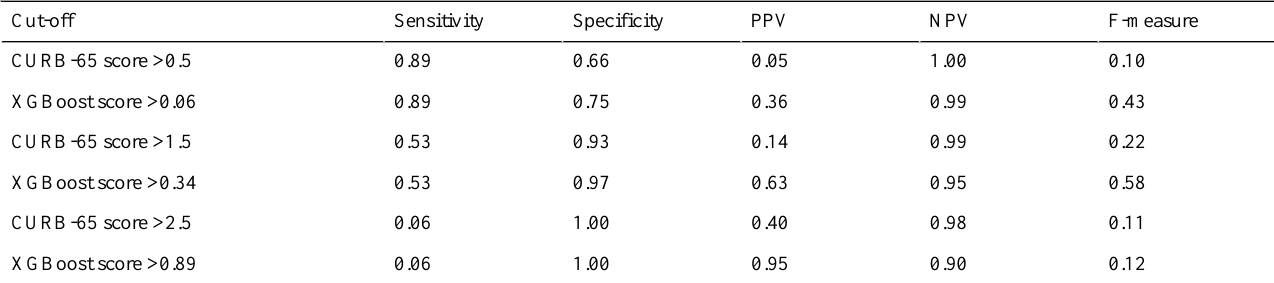
Table 2. Sensitivity, specificity, positive predictive value (PPV), negative predictive value (NPV), and F-measure for the machine learning model and the CURB-65 (confusion, urea, respiratory rate, blood pressure, and 65 years of age or older) score, with different cut-offs.